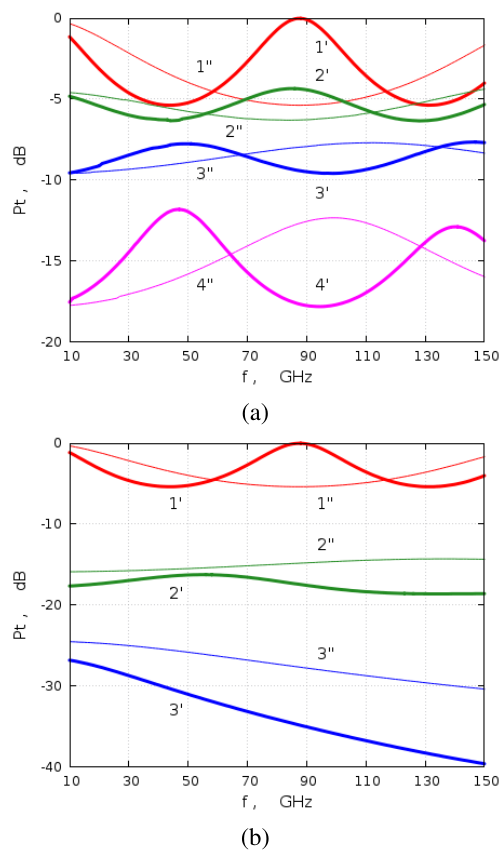
Figure 7: MM wave transmission through 0.5 mm and 0.25 mm Si wafer (prime and double-prime curve numbers, respectively) in the dark state (curves 1) and under the uni- form (a) red light and (b) IR radiation with no grating mask at the light power fluxes P L = 0 . 01 , 0 . 03 , 0 . 1 kW/cm 2 (curves 2 to 4,